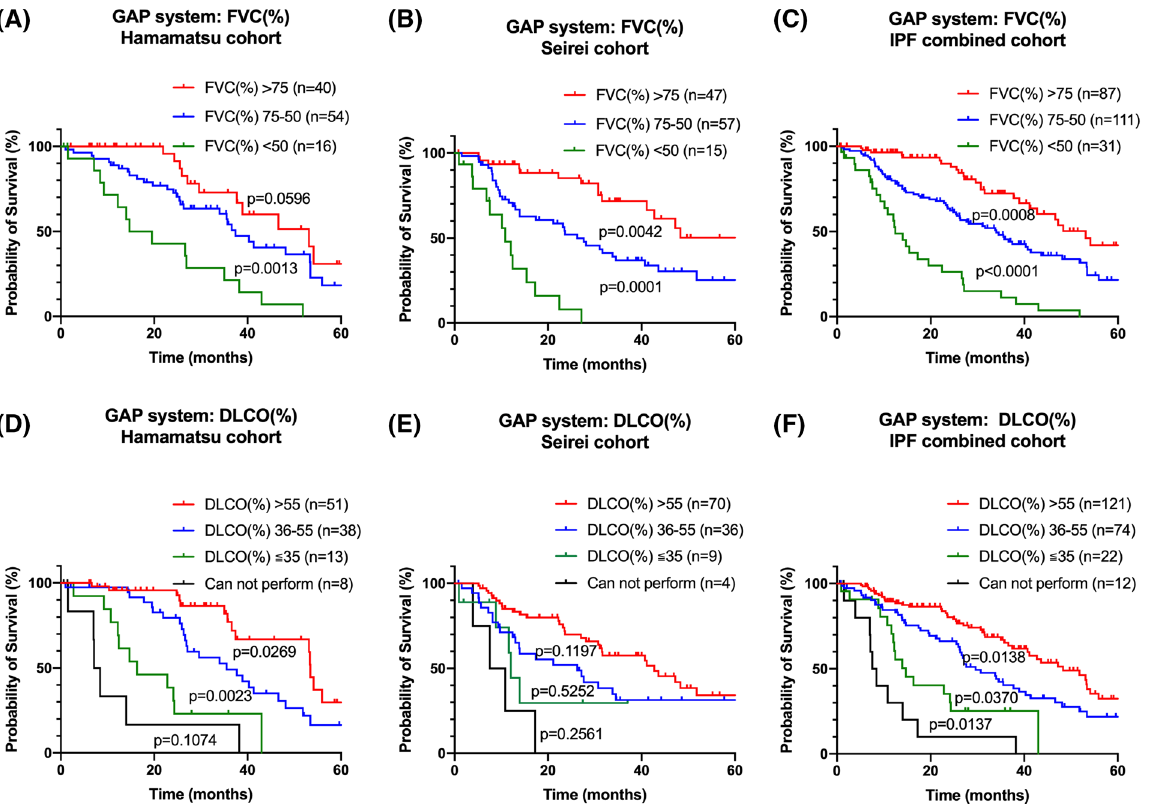
Figure 3. Prognostic classifications according to GAP index: FVC (%) and GAP index: DLCO (%). Kaplan– Meier curves based on the data of the patients with IPF of the Hamamatsu cohort (A,D) , Seirei cohort (B,E) , and combined cohort (C,F) according to GAP stage: FVC (%) and GAP index: DLCO (%). P values were determined using the log-rank test. GAP Gender-Age-Physiology, FVC forced vital capacity, DLCO diffuse capacity of the lung for carbon monoxide, IPF idiopathic pulmonary